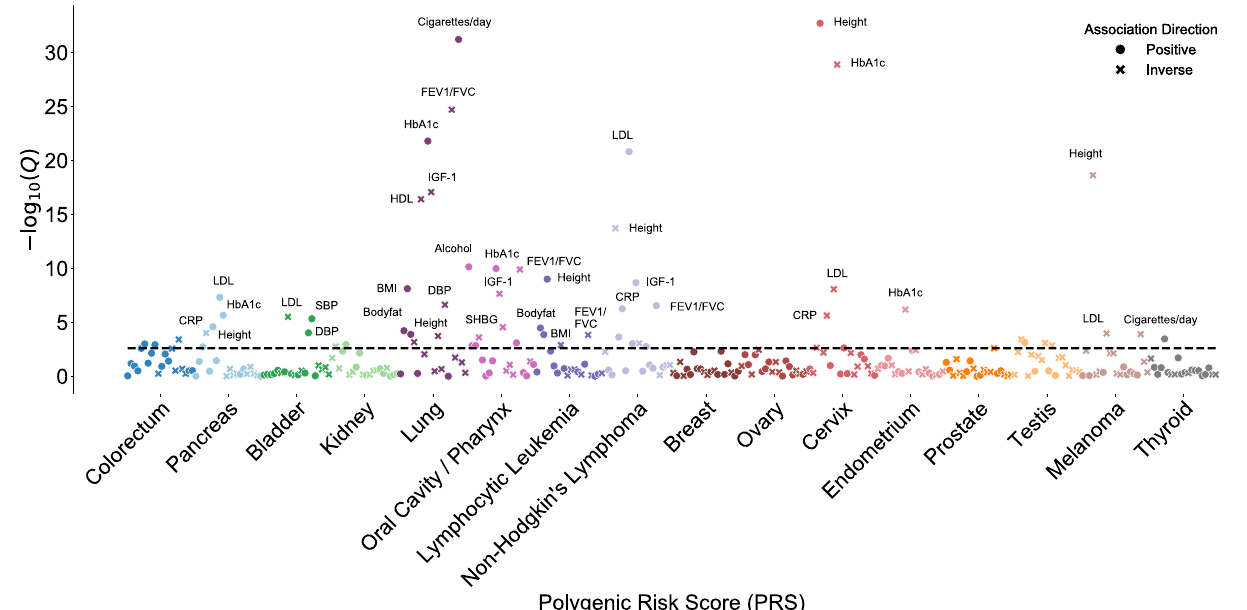
Fig. 3 Associations between each cancer-speci fi c polygenic risk score (PRS) and 20 cancer risk factors and related serum biomarkers. All associations were estimated in cancer-free controls in the UK Biobank. Circles denote positive associations between the PRS and the secondary phenotype; crosses denote an inverse direction of the association. Odds ratios (ever/never smoking status) were estimated from logistic regression models, and p values were calculated from two-sided Wald tests. Risk ratios (remaining phenotypes) were estimated from linear regression models, and p values were calculated from two-sided t tests. The dashed line indicates the signi fi cance threshold corrected for multiple testing ( p < 0.05/20 =